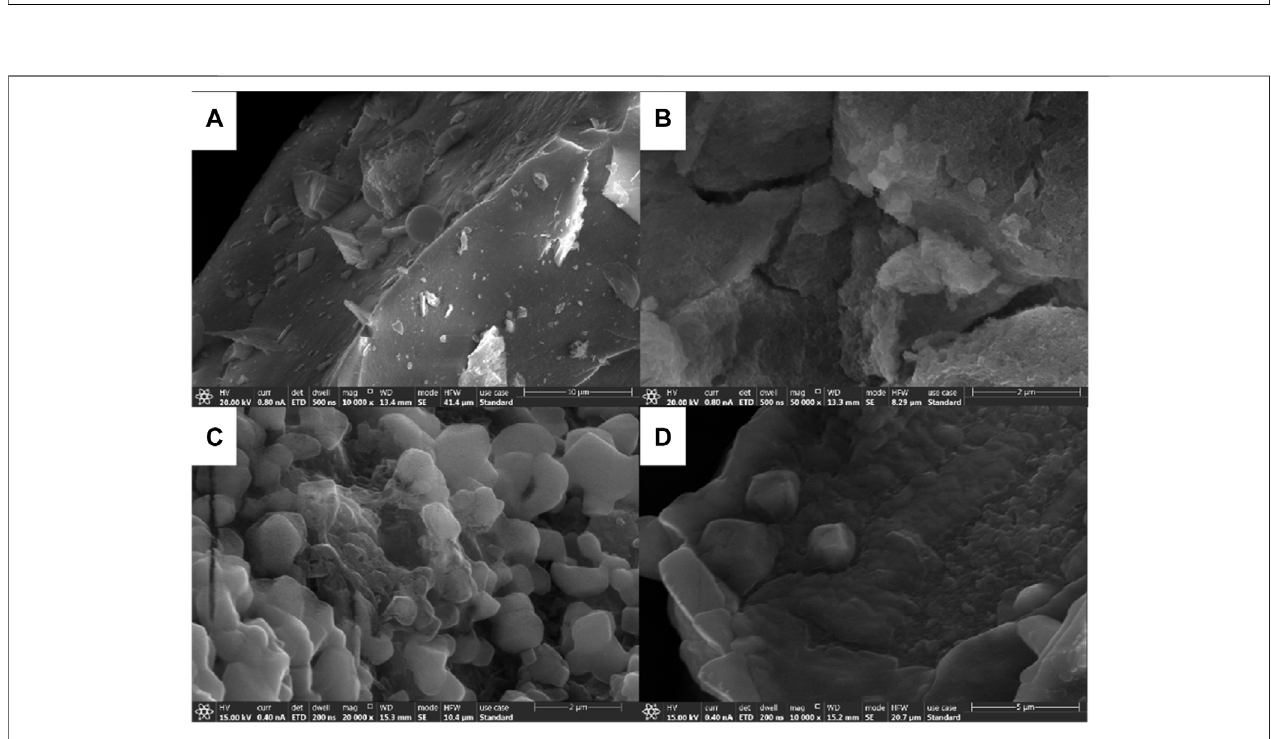
FIGURE 14 | SEM images of mineral polymeric precursors with different Si/Al ratios. (A) Si/Al=10:1; (B) Si/Al=1:1; (C) Si/Al=1:10; (D) Si/Al=1:20